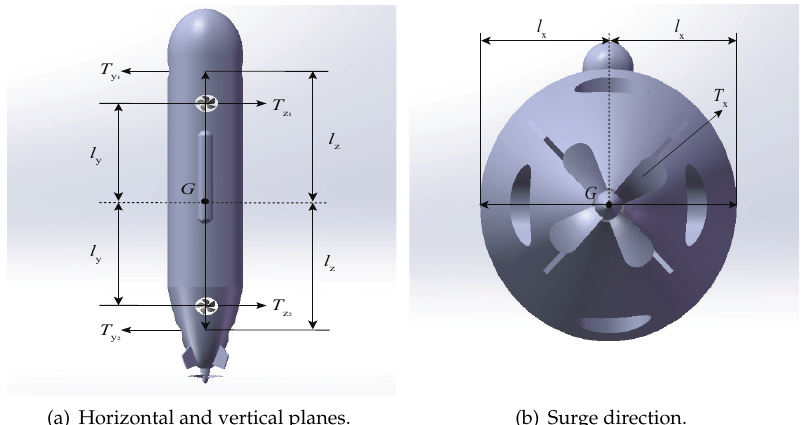
Figure 2. Schematic diagram of propeller